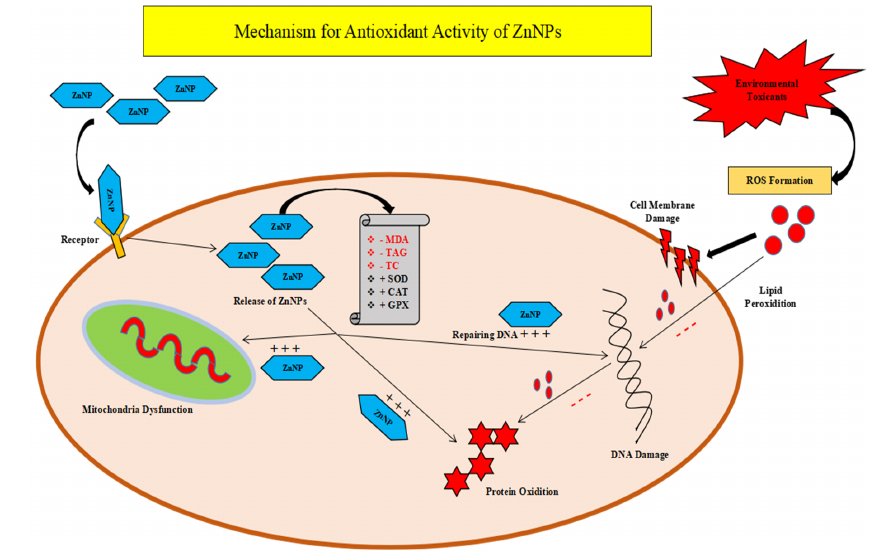
Figure 3. Initially Zn NPs attached to membrane bounded receptors and are able to enter animal cells. Cell membrane damage, lipid peroxidation, protein oxidation, DNA damage, and mitochondrial dysfunction caused due to environmental factors medicated through Zn NPs. Enzyme level increase in animal cell, i.e., superoxide dismutase (SOD), catalase (CAT), glutathione peroxidase (GPX), but a reduction in enzyme level of malondialdehyde (MDA), total antioxidant capacity (TAC), and total